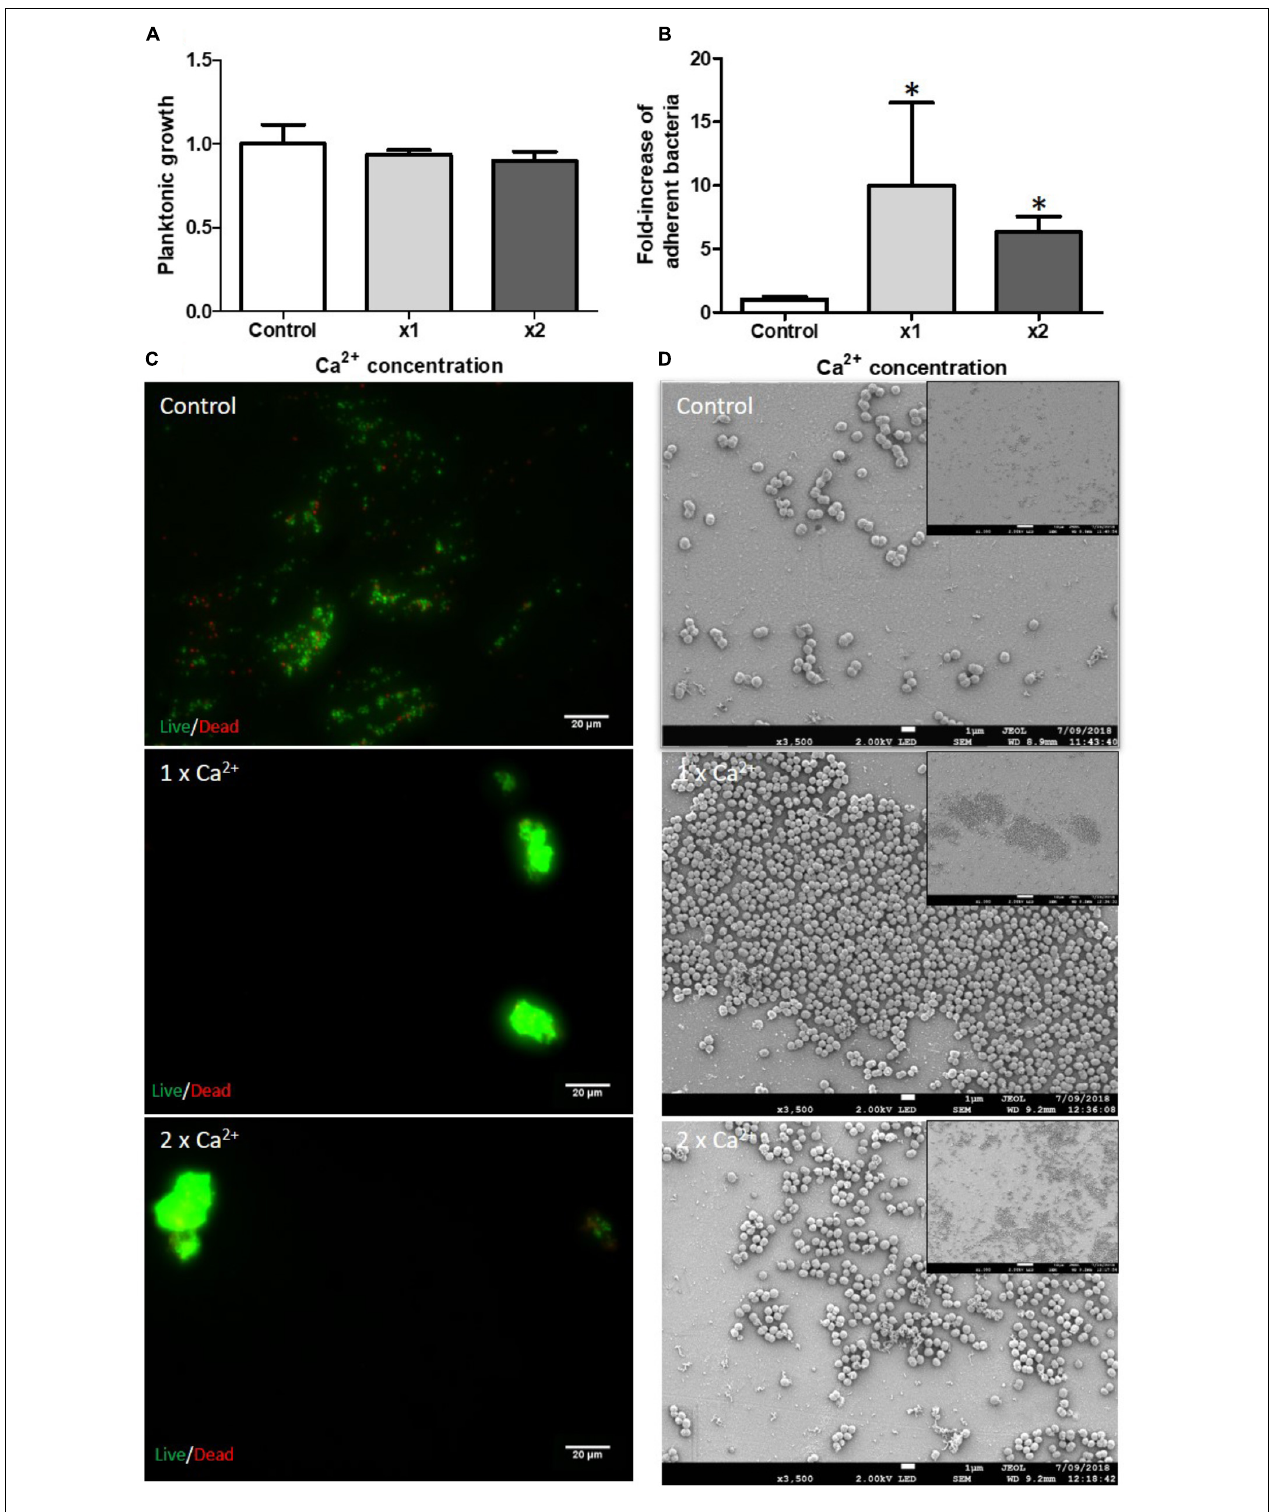
FIGURE 1 | Impact of Ca 2 + on S. aureus biofilm formation. Planktonic growth normalized on control (A) and fold-increase of live adhered cells (B) . Ca 2 + × 1 and × 2 serological concentration (=1.2 mM). ( n = 9). ∗ Statistically significantly different from control ( p < 0.05). Fluorescence microscopy (C) with live (green color)/dead (red color) staining. Scale bar = 20 µ m. Scanning Electronic Microscopy (SEM) (D) . Main panels: scale bar = 1 µ m and insert panels showing the homogeneity on a wide field: scale bar = 10 µ m.